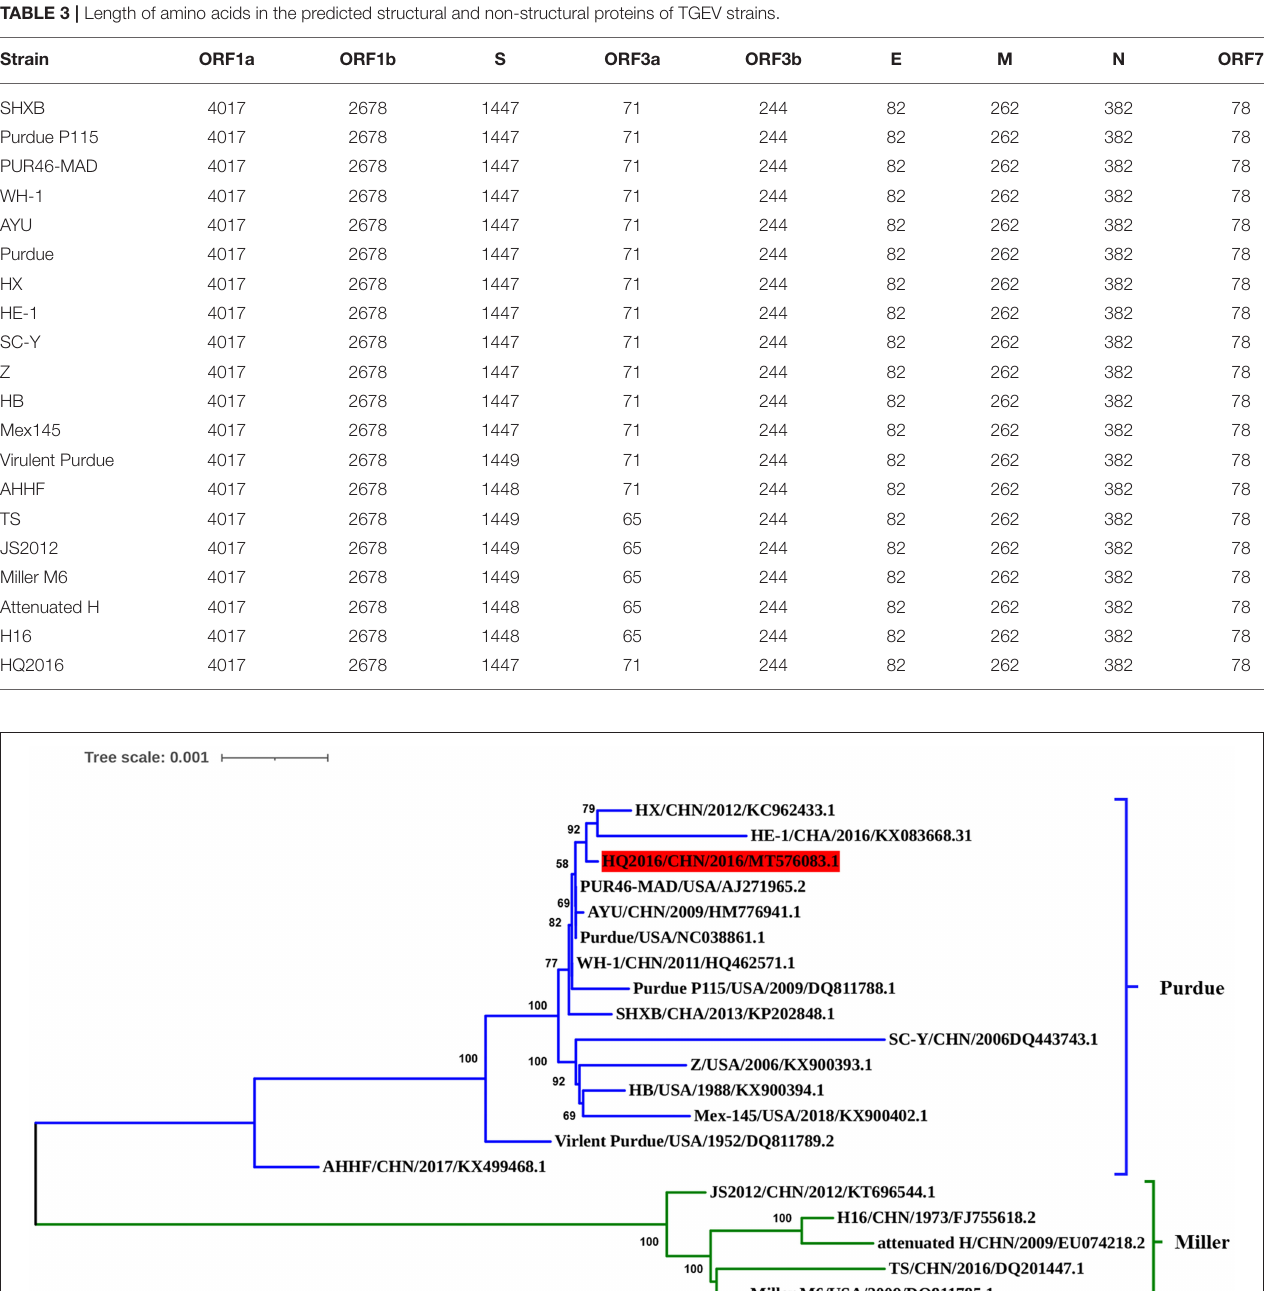
84 hpi, the viral level was highest in the jejunum (7.21 ± 0.11 log 10 RNA copies/g), and then (in decreasing order) in